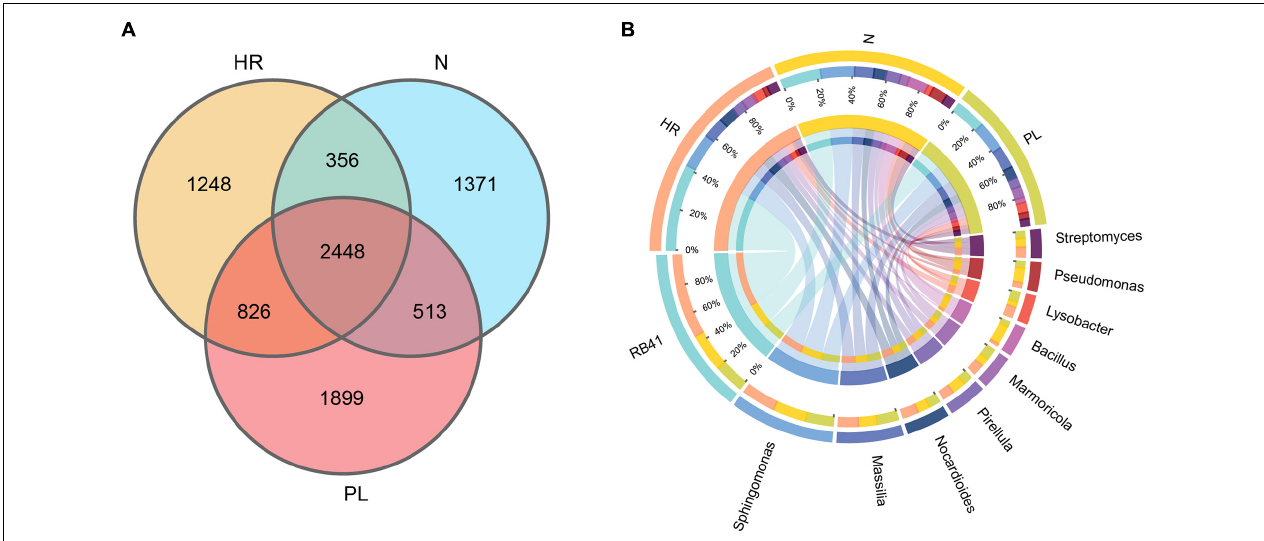
FIGURE 2 | Venn diagram of rhizosphere-enriched bacterial OTUs in rhizospheric soils from the three field types. (A) Venn diagram representing the bacterial OTUs associated with the rhizosphere of C. yanhusuo . (B) CIRCOS diagram illustrating the taxonomic representation of differences between N, HR and PL fields. The width of each ribbon represents the abundance of each taxon. N, soil from the C. yanhusuo field without rotation; HR, soil from the C. yanhusuo field that had been flooded in July 2020; PL, soil from the field under peanut– C. yanhusuo